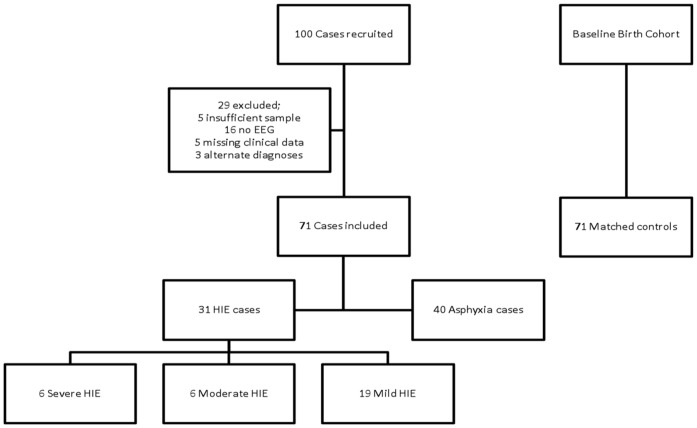
Flow diagram detailing enrolment of study infants.